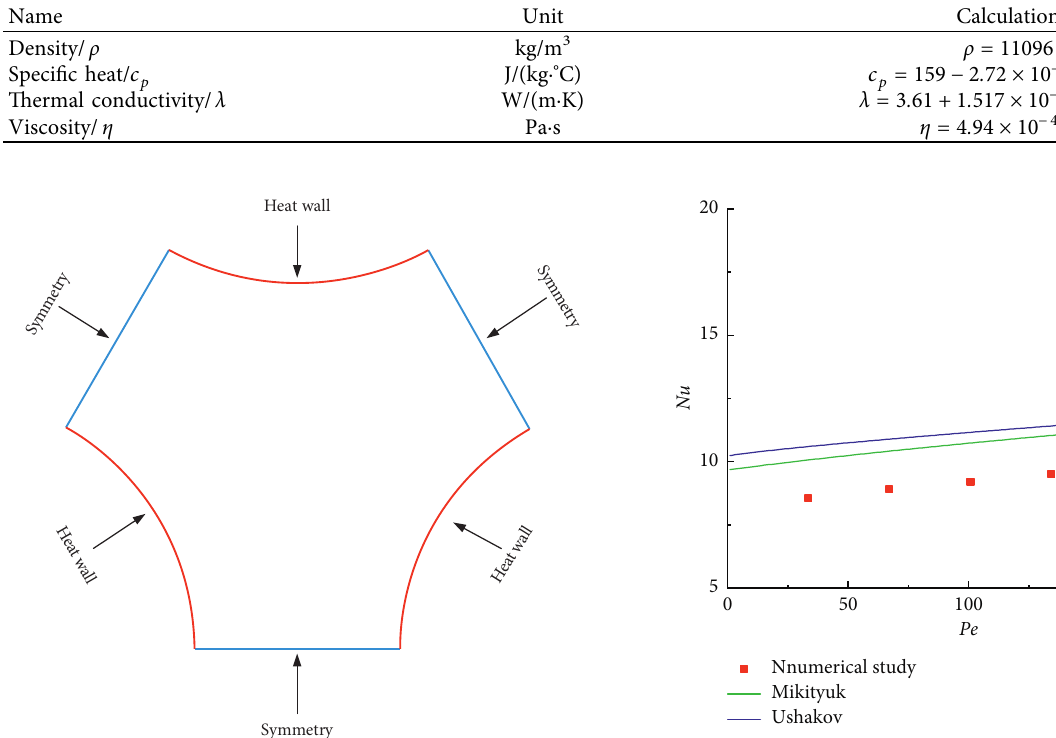
Figure 3: Boundary condition of the wall.